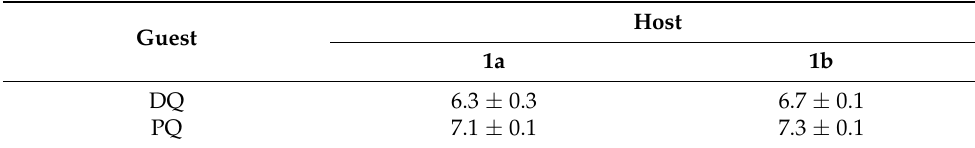
Table 5. Association constants of H-G complexes at 25 ◦ C, reported as log K . Paraquat, PQ, and diquat, DQ, are the guests, G, and the compounds 1a and 1b are the fluorescent hosts, H. The values were determined by Equation (1). Uncertainties are given as standard